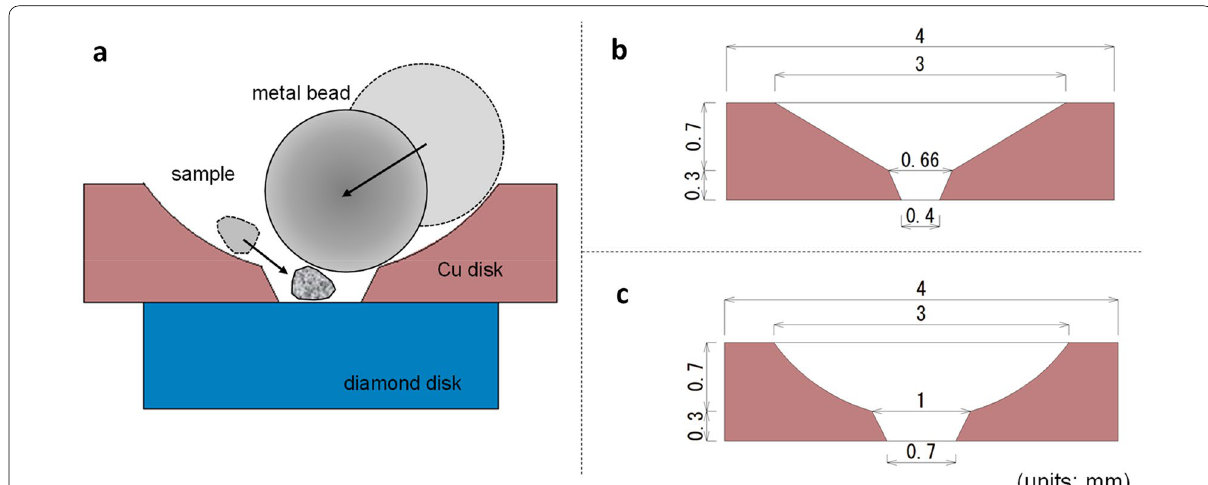
Fig. 3 Schematic diagram of the pelletization and cross-section images of the Cu pelletization disks for different sample sizes. a . A sample was placed in the conical hole of the Cu disk and pressed against the diamond disk with the metal bead. b . Cu disk for smaller samples of 0.5 mm diameter. c . Cu disk for larger samples of 1 mm